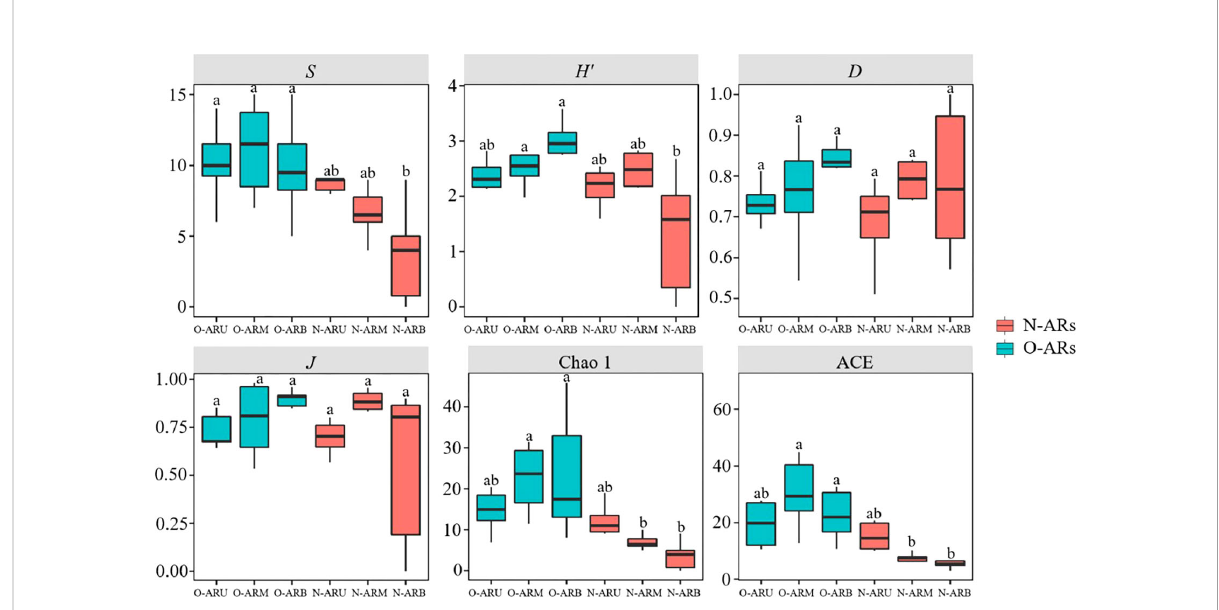
FIGURE 5 a -Diversity analysis of attached communities at each sampling location on the ARs with different construction times: species richness index ( S ), Shannon index ( H ′ ), Simpson index ( D ), evenness index ( J ), Chao1 index and abundance-based coverage estimator (ACE). Different letters (a,b) above the bars indicate signi fi cant differences between sampling locations.